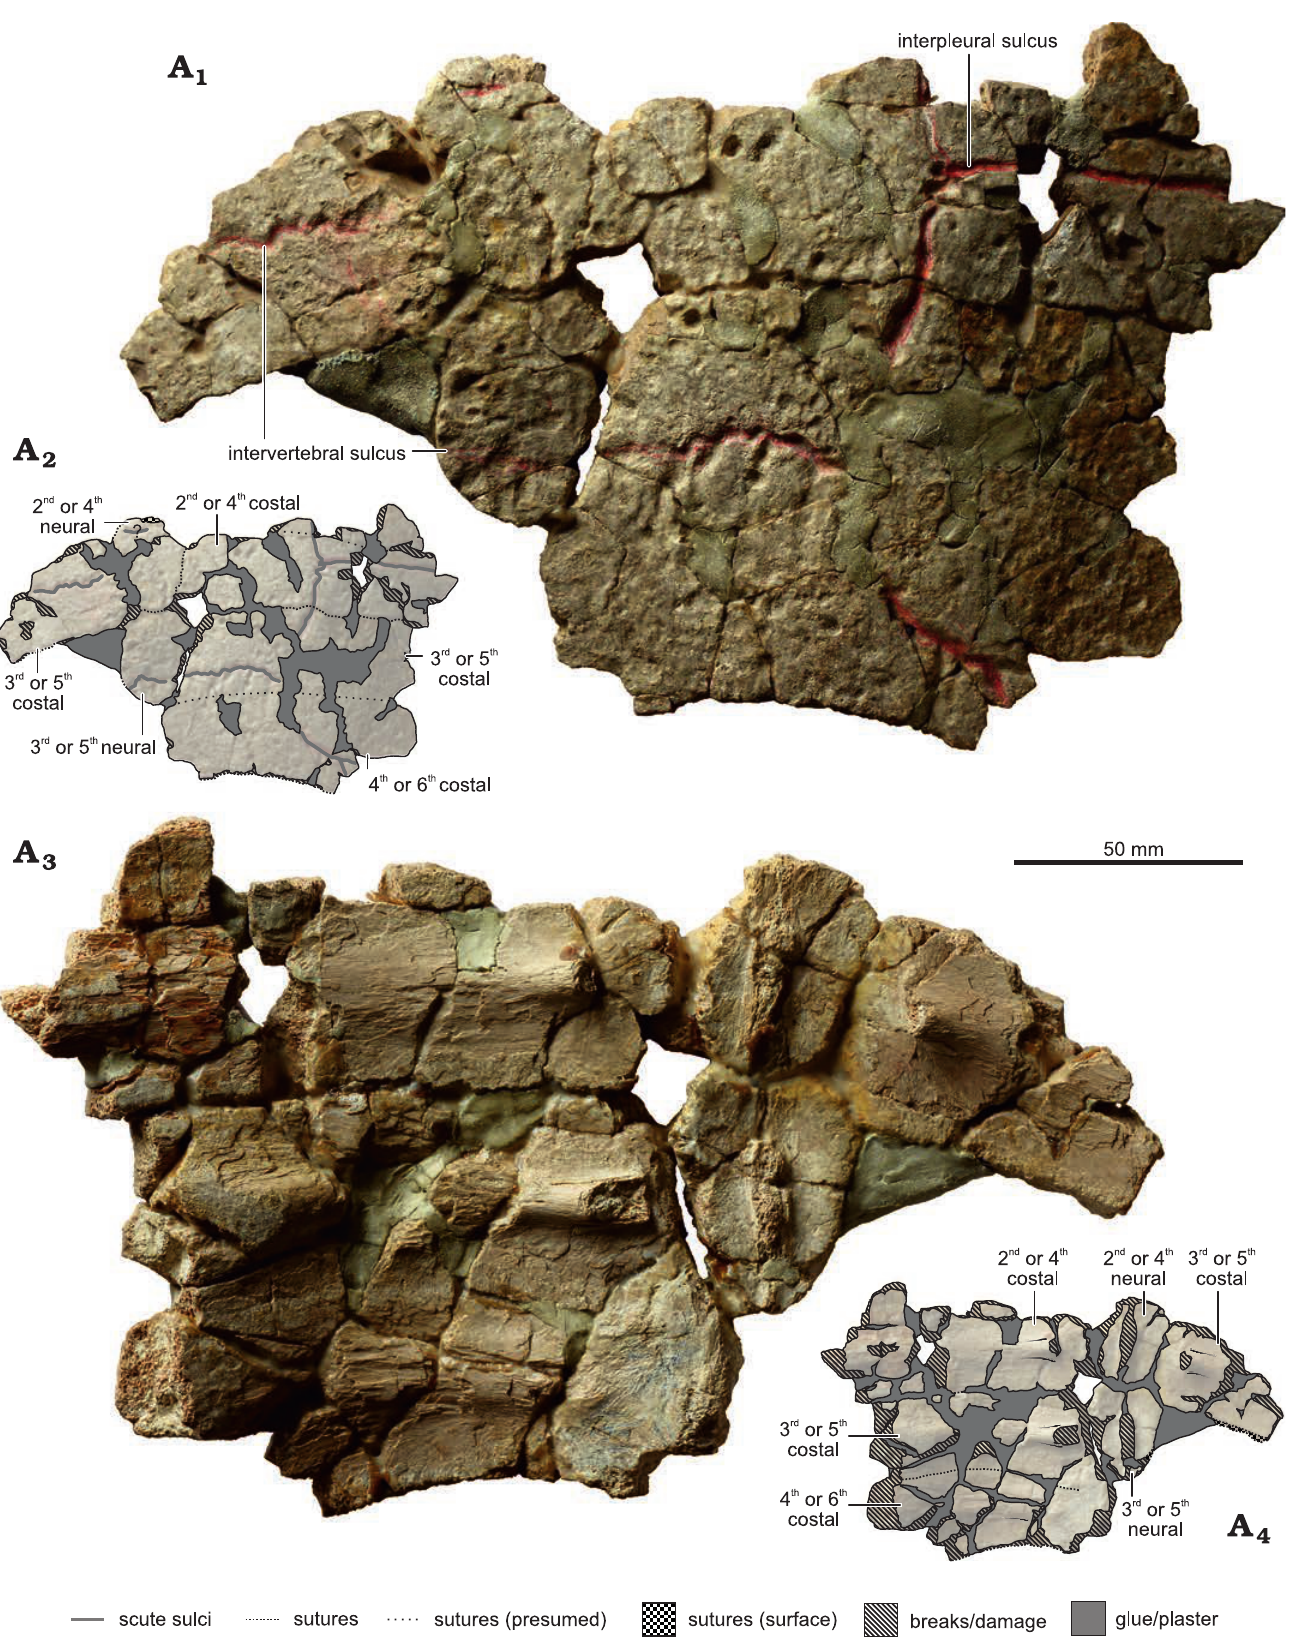
Fig. 2. The thalassochelydian turtle Craspedochelys ? sp., MZ VIII Vr-71, from the Kimmeridgian of Krzyżanowice. Central part of the carapace (Fig. 6A: 1), in external (A 1 , A 2 ) and visceral (A 3 , A 4 ) views. A 1 , A 3 , photographs; A 2 , A 4 , explanatory